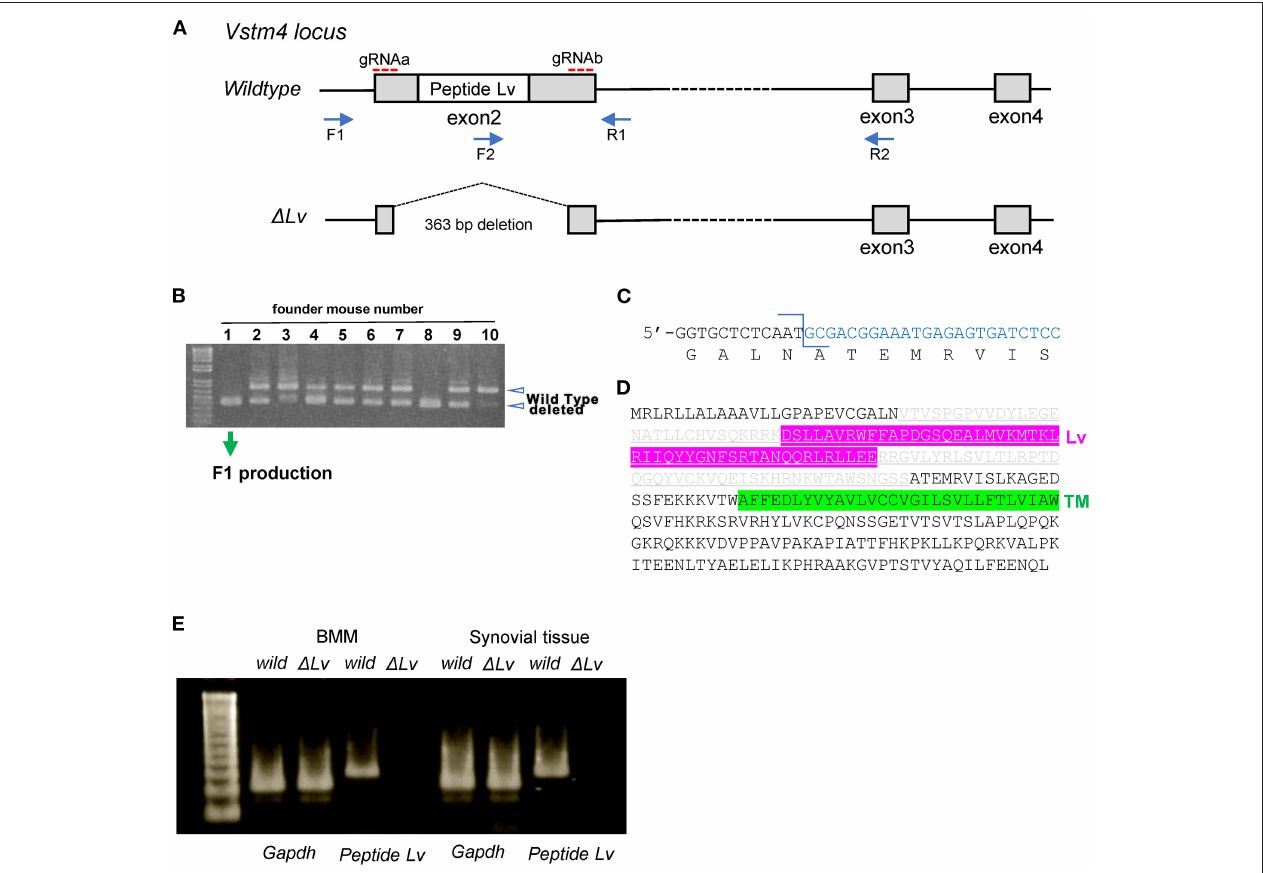
FIGURE 3 | Generation of peptide Lv -deficient mice. (A) A map of the mouse Vstm4 locus showing the target regions of the gRNAs and primers used for polymerase chain reaction (PCR). (B) Results of genotyping using PCR to screen for peptide Lv -deficient founder mice. (C) The sequence at the junction of the deleted genes. (D) The predicted amino acid sequence of deleted peptide Lv in mouse line No. 1M1. Gray letters are the deleted amino acid sequences. (E) Results of RT-PCR to confirm the depletion of Lv.